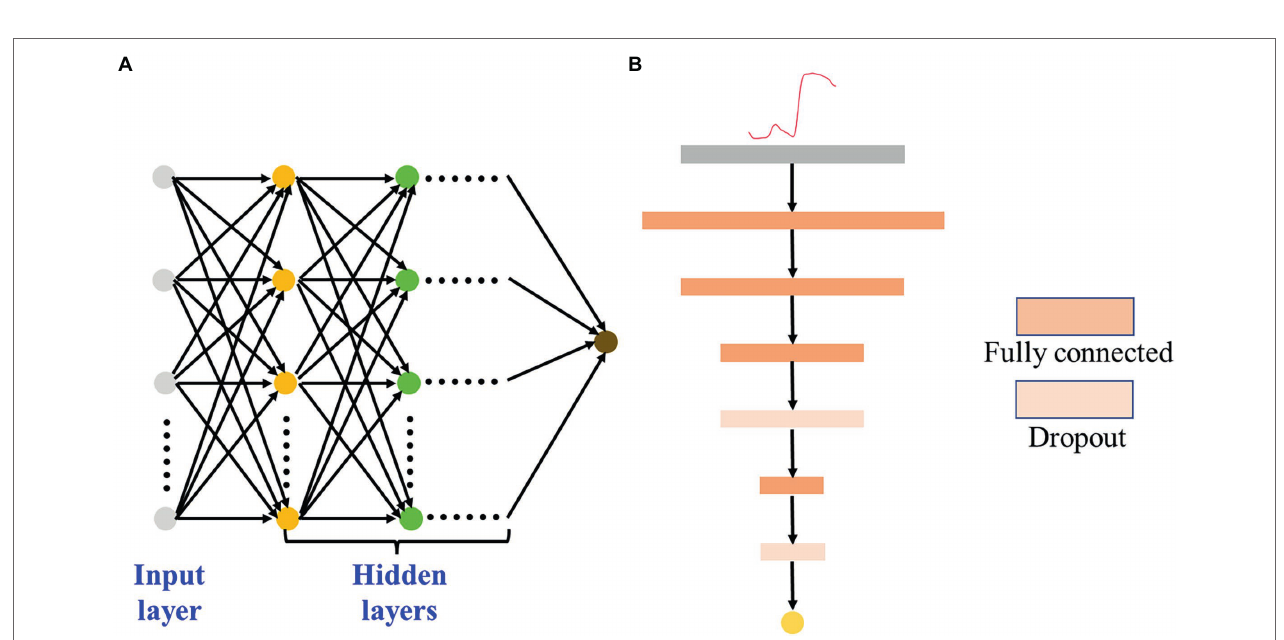
FIGURE 4 | FCNN schematic chart (A) and architecture of the DeepFC (B)